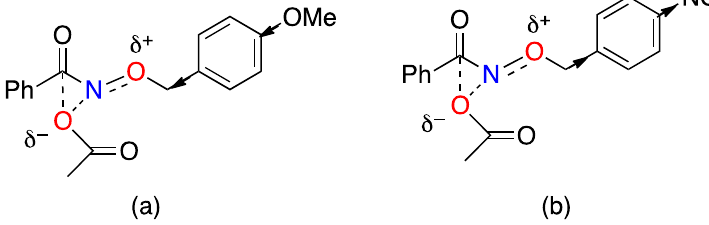
Figure 15. ( a ) Stabilisation of the HERON transition state for N -acyloxy- N -alkoxyamides by para methoxyl group and ( b ) destabilisation by a para nitro group.